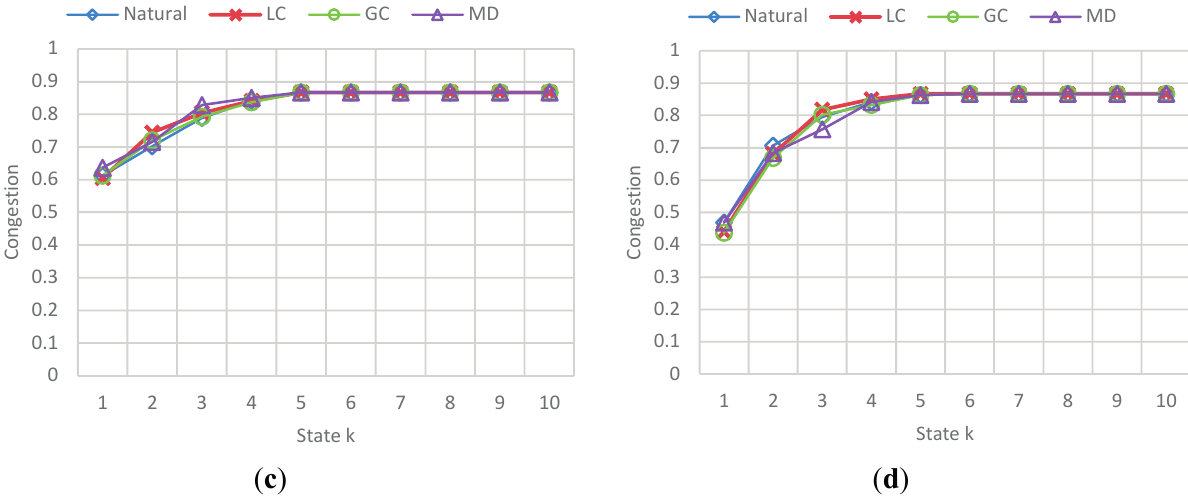
Figure 28. Obtained Average Congestion in a state k for each F-vehicle value. ( a ) Avg. congestion obtained in a state k when F is 10; ( b ) Avg. congestion obtained in a state k when F is 20; ( c ) Avg. congestion obtained in a state k when F is 30; ( d ) Avg. congestion obtained in a state k when F is